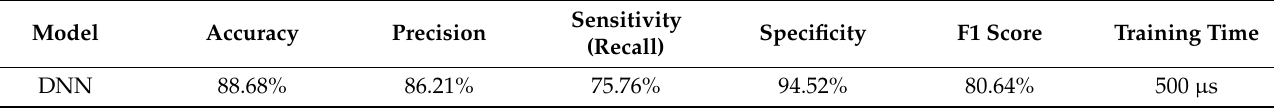
Table 9. Confusion matrix indicators: DNN.